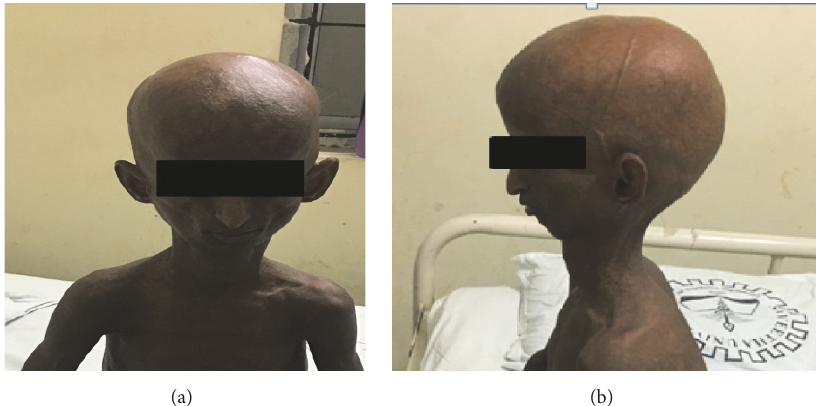
Figure 6: Real life pictures of the 16-year-old male patient with bird-like facies: (a) en face view and (b) profile